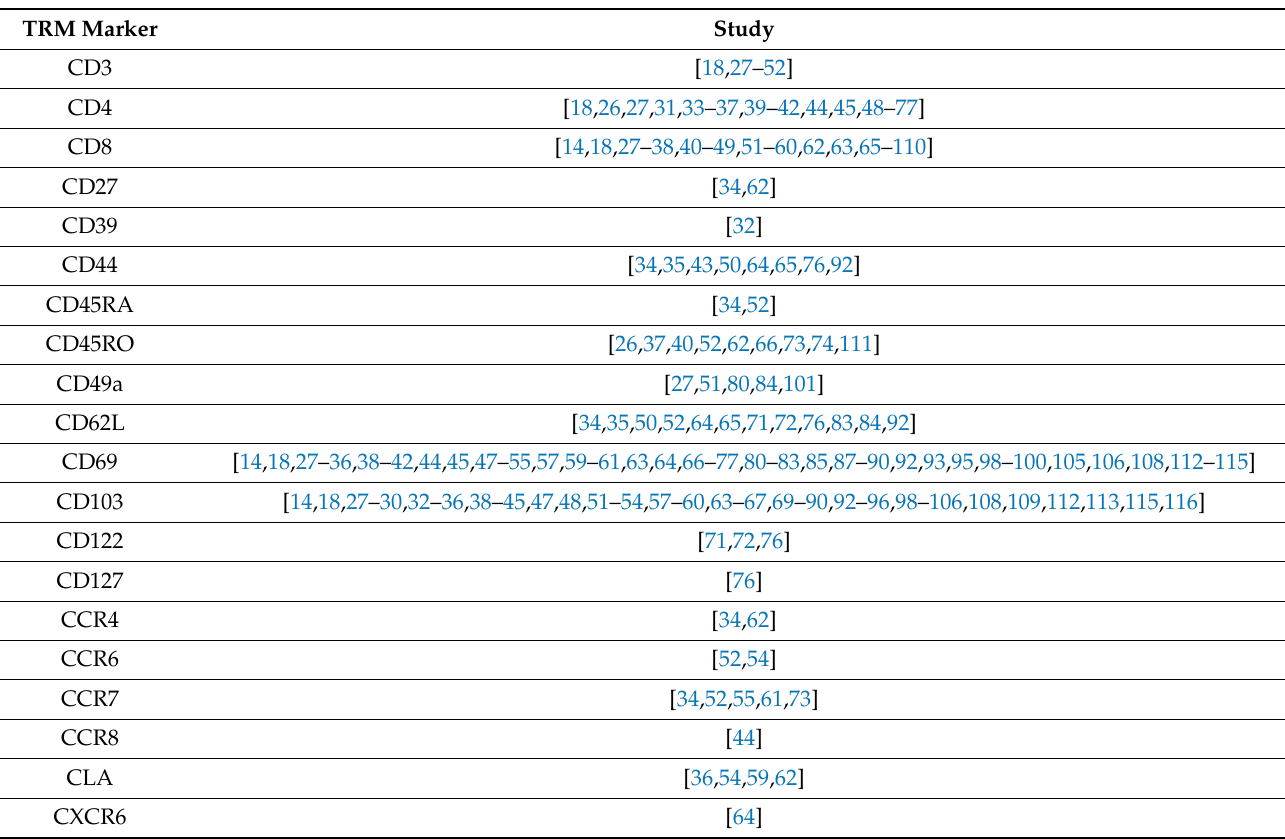
Table 1. Tissue-resident memory T (TRM) cell markers used by authors to define skin TRM cells. Often, a combination of markers was used. For the most part, TRM cells were either defined as CD3 + , CD4 + or CD8 + T cells with an expression or absence of different markers. CD49a ( α -subunit of the α 1 β 1 integrin receptor) is another marker with important delineating functional implications. CD69 suppresses sphingosine-1-phosphate receptor 1 expression, which prevents T cell egress from tissues into the circulation. CD103 binds E-cadherin on epithelial cells, which mediates retention of T cells in the skin. TRM